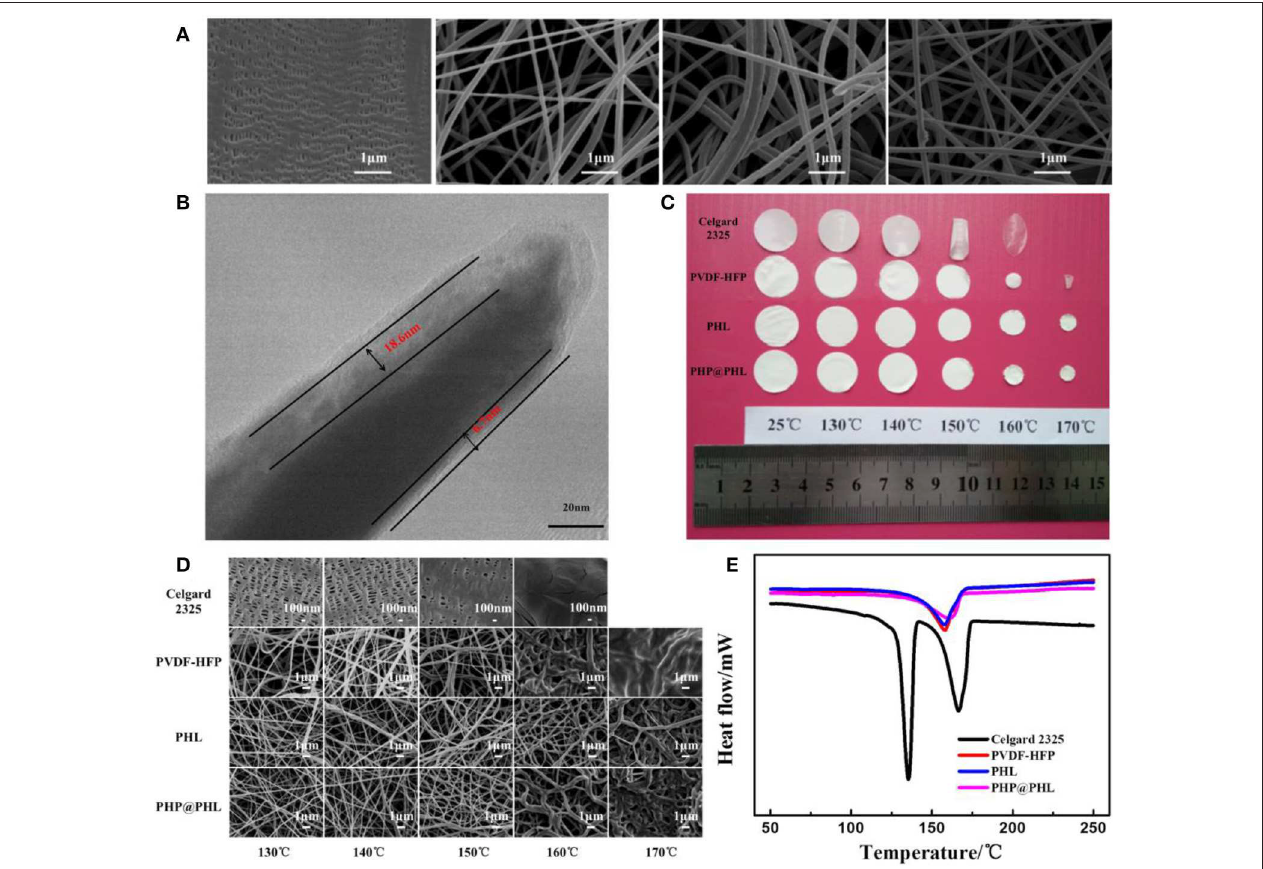
FIGURE 1 | (A) SEM images of the various separators, Celgard 2325, nanofibrous PVDF-HFP, PHL, and PHP@PHL; (B) TEM micrograph of the PHP@PHL fibers; (C) Picture of Celgard 2325, PVDF-HFP, PHL, and PHP@PHL separators and their macroscopic changes after heat treatment at different temperatures, (D) SEM